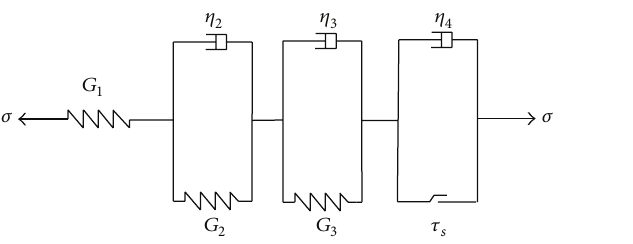
Figure 6: Nonlinear shear creep model of frozen